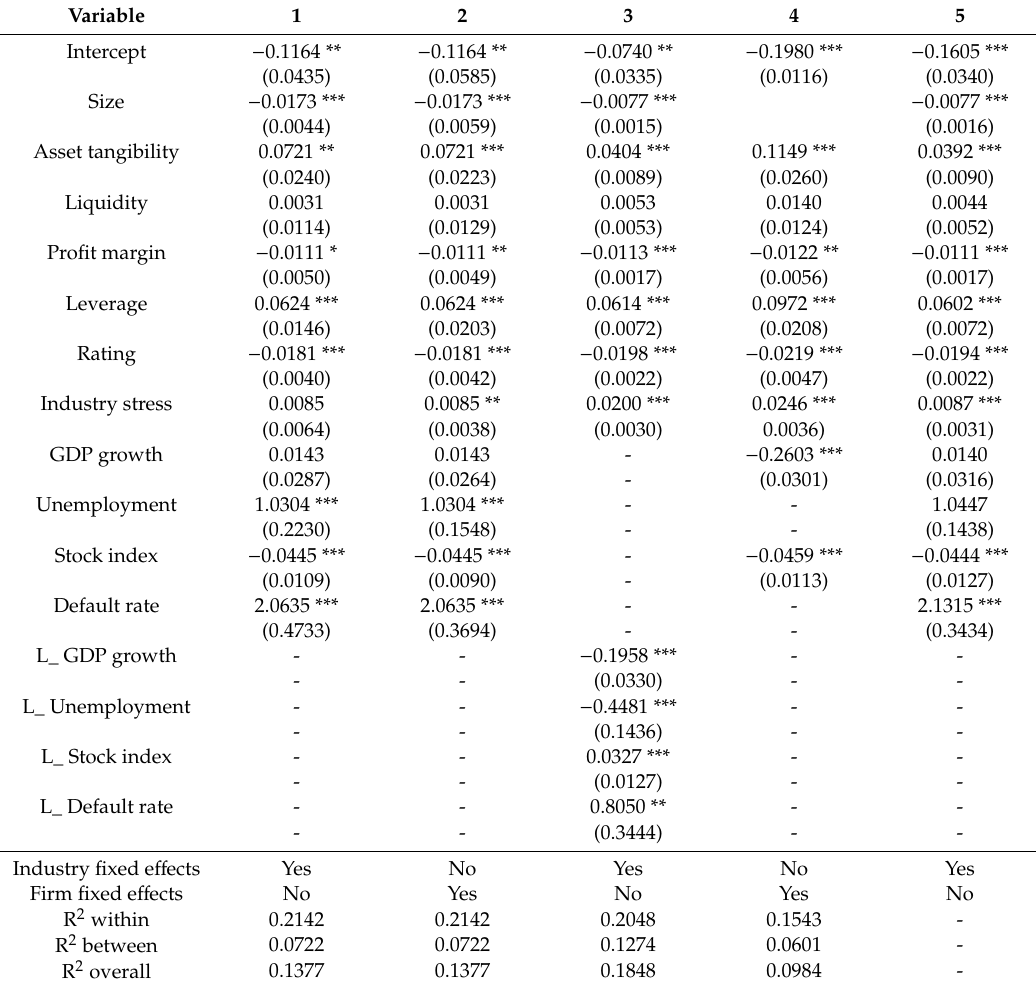
Table 8. Regression results for the slope of market-implied recovery rates. Robust standard errors are reported in parentheses. Variables preceded by “L_” are lagged by one quarter. Statistical significance at the 10%, 5% and 1% level is indicated by superscript *, ** and ***,